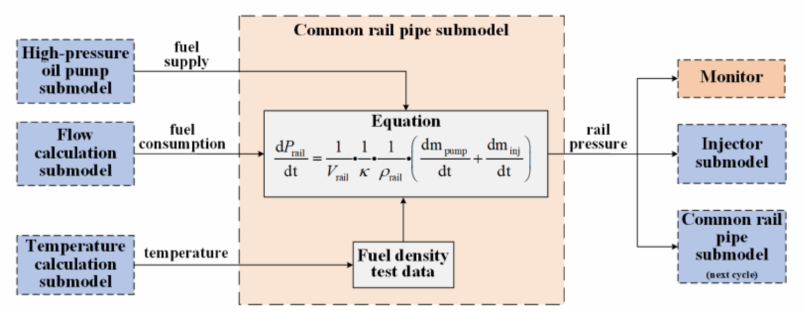
Figure 13. Development process of the common rail pipe submodel.